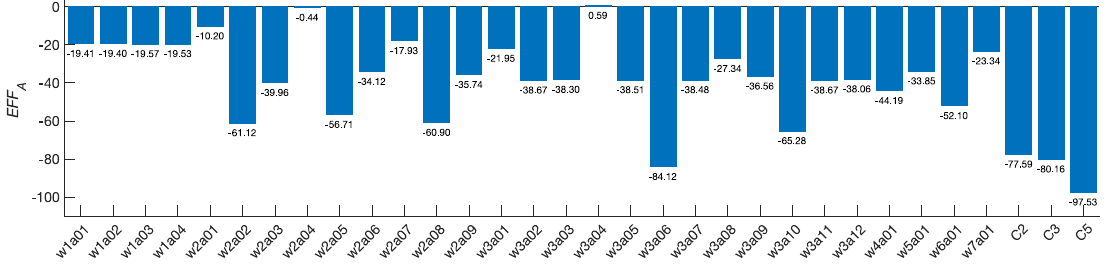
Figure 16. Efficiency scores for the different architectures in the literature. Values that are more negative represent greater energy savings